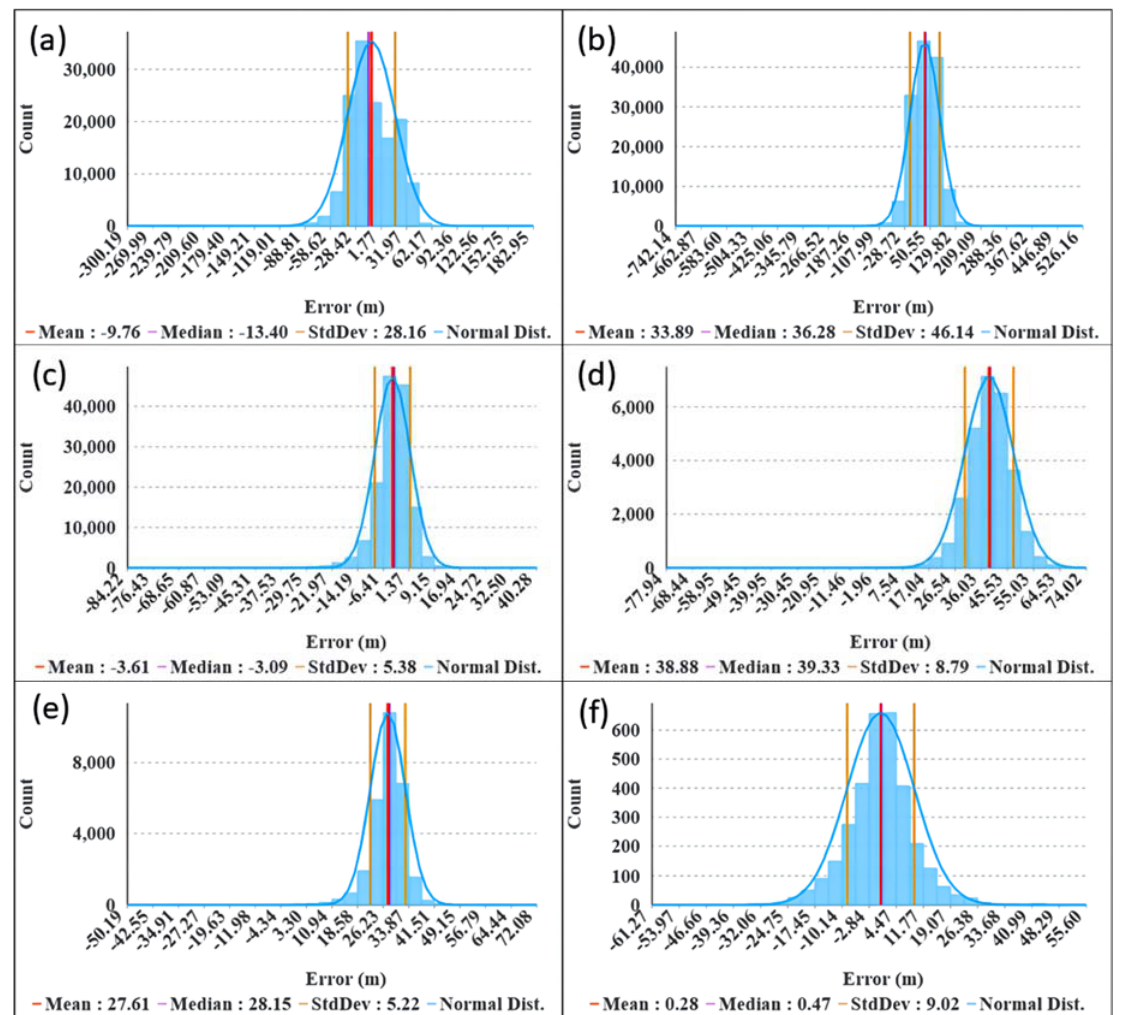
Figure 8. Statistical histograms of the elevation errors based on the UAV DSM reference: ( a – f ) correspond to errors in the statistical histograms of the ascending InSAR DEM, descending InSAR DEM, ALOS PALSAR DEM, ASTER Global DEM V3, SRTM V3 DEM, and TanDEM, respectively.